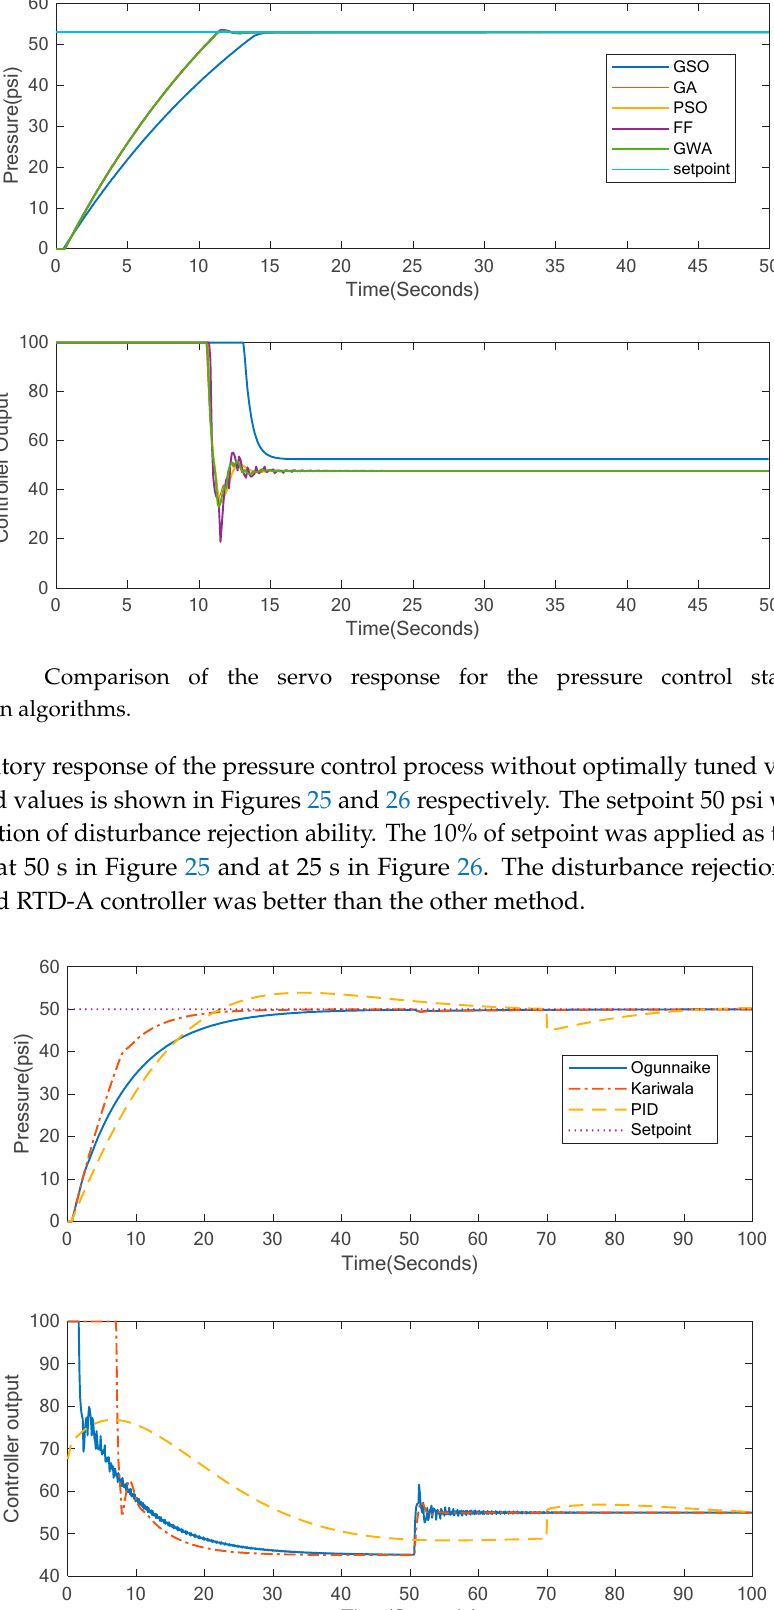
Figure 23. Comparison of the servo response for the pressure control station with two tuning rules and PID.